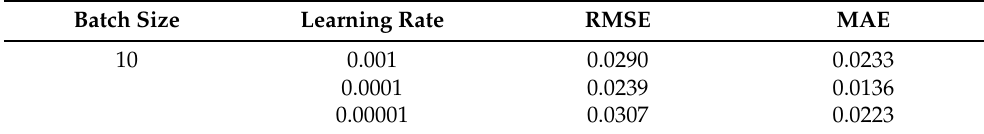
Table 2. Results of validation set prediction with different learning rates.